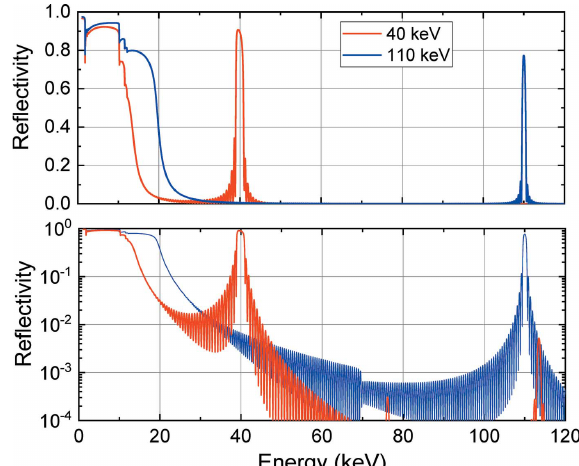
Figure 3 Calculated multilayer reflectivities (single reflection) plotted as functions of the X-ray energy for the 40 keV and 110 keV multilayer mirrors. The vertical axes of the graphs are drawn in linear (upper) and log (lower)